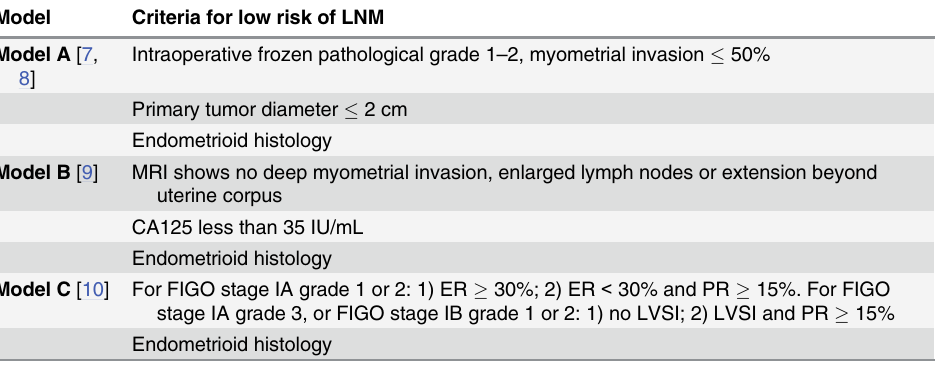
Table 1. Description of three reported prediction models for lymph node metastasis (LNM) in endome- trial cancer.